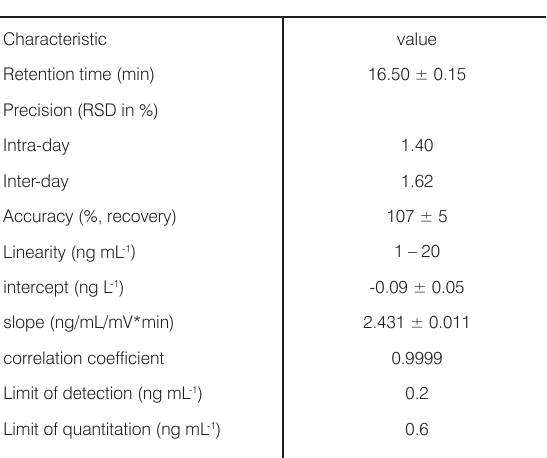
Table 1. Method characteristics of HPLC determination of OPP.